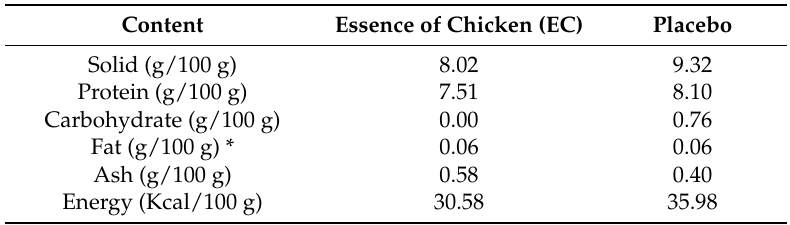
Table 1. Nutritional content of study investigational